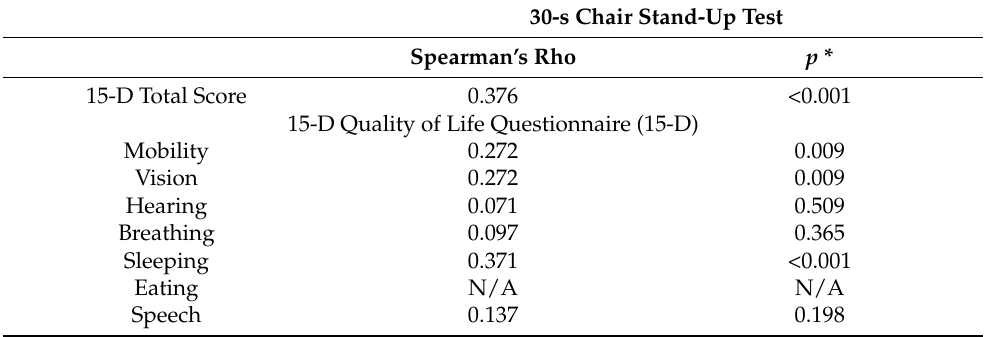
Table 3. Correlations between the 30-s chair stand-up test and the 15-dimensional (15-D) quality of life questionnaire dimensions and the total score in the type 2 diabetes mellitus population ( n =